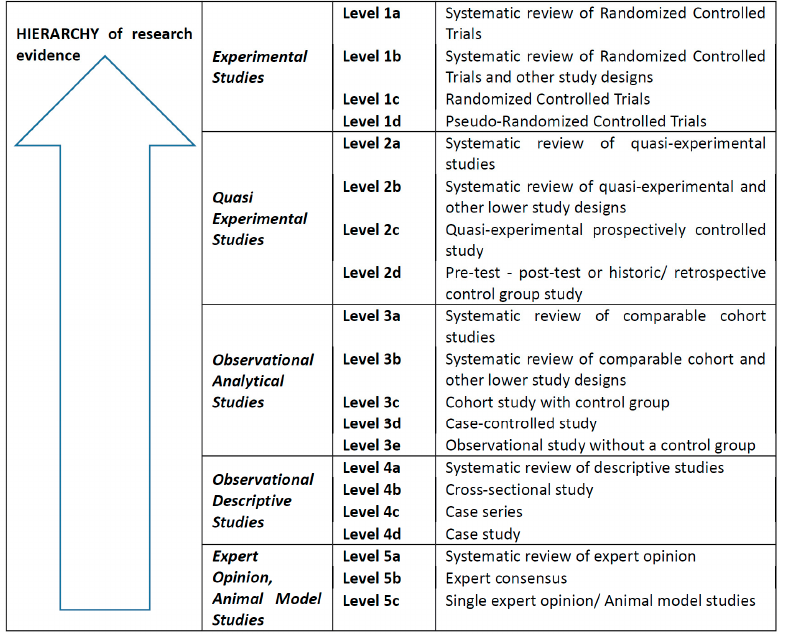
Figure 1. Levels of evidence in quantitative research [34].